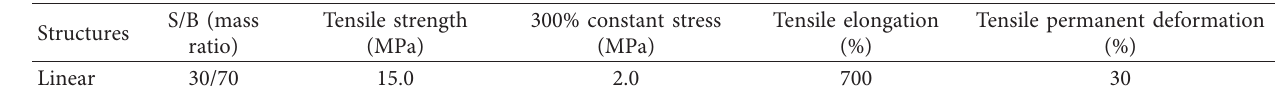
Table 3: Physical properties of SBS copolymer.